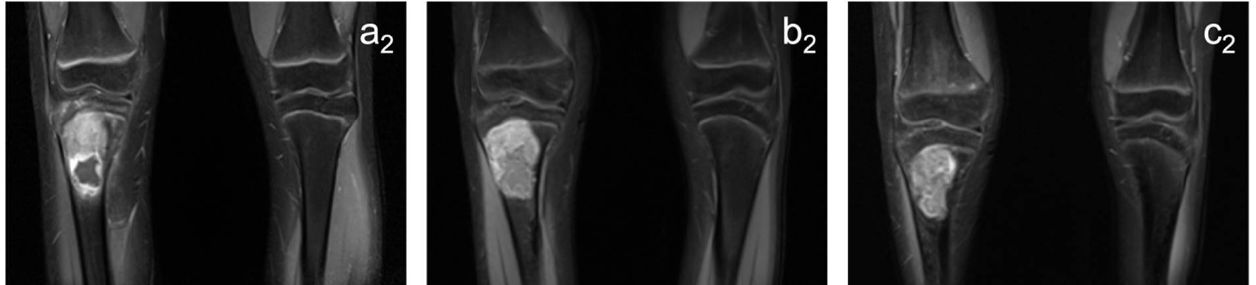
Figure 1. Images of a patient with a Ewing sarcoma in the proximal right tibia. The tumor shows a pathologic glucose metabolism (SUVpeak: 7.2) and a maximum diameter of 64 mm at the prethera- peutic scan: (( a 1 ): PET/MRI; ( a 2 ) MRI). The metabolic activity decreases significantly under treatment (PET/MRI; ( b 1 ): first follow-up, SUVpeak: 1,9 (−73.6%); ( c 1 ): second follow-up, SUVpeak: 1,7 (−76.4%)), but the tumor reveals only a slight decrease in size (MRI; ( b 2 ): first follow-up, 57 mm (−10.9%); ( c 2 ): second follow-up, 53 mm (−17.2%)). Histopathological analysis after tumor resection did not reveal vital tumor (reference standard: complete response).